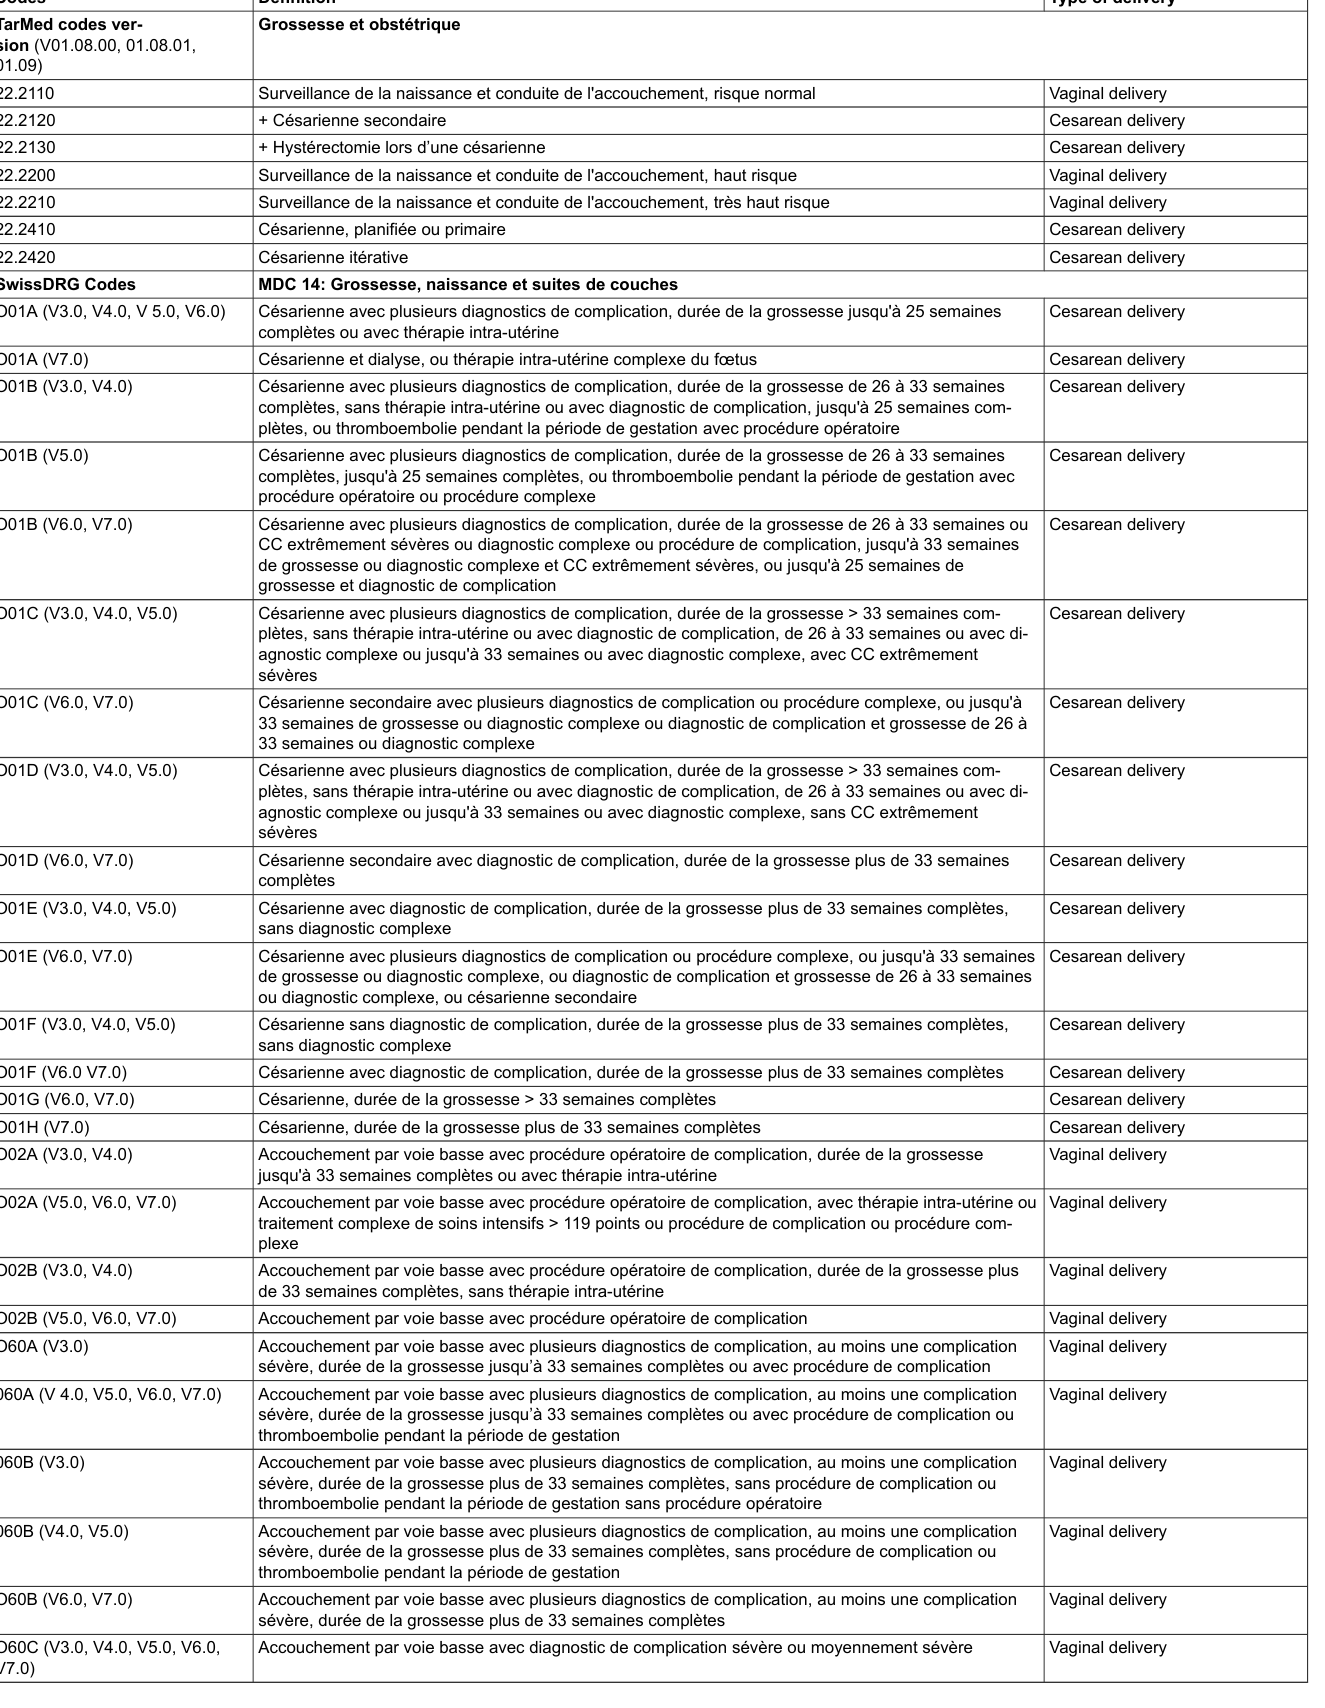
Table S5: Relevant codes to identify vaginal or caesarean